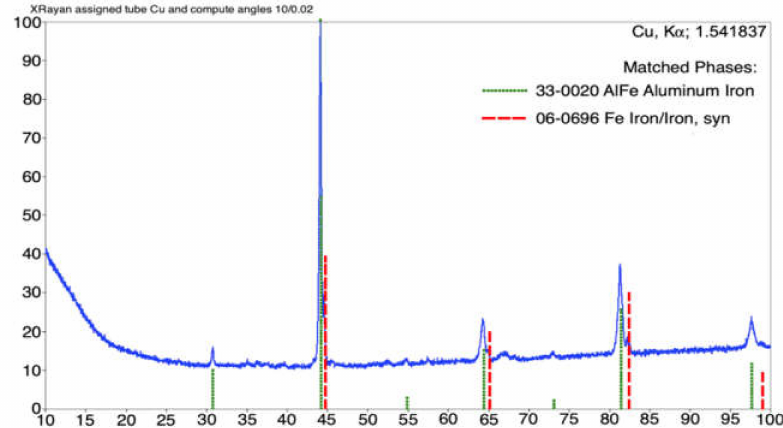
Figure 11. XRD diffraction pattern of the arc-sprayed Fe-Al coating after 900 ◦ C